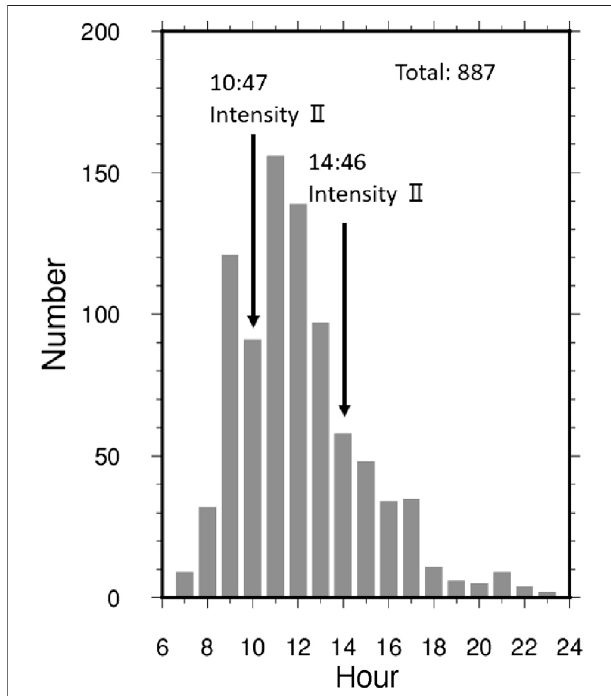
FIGURE 3 | Hourly volcano-tectonic earthquake occurrences from 6:00 to 23:59 JST on August 15, 2015.